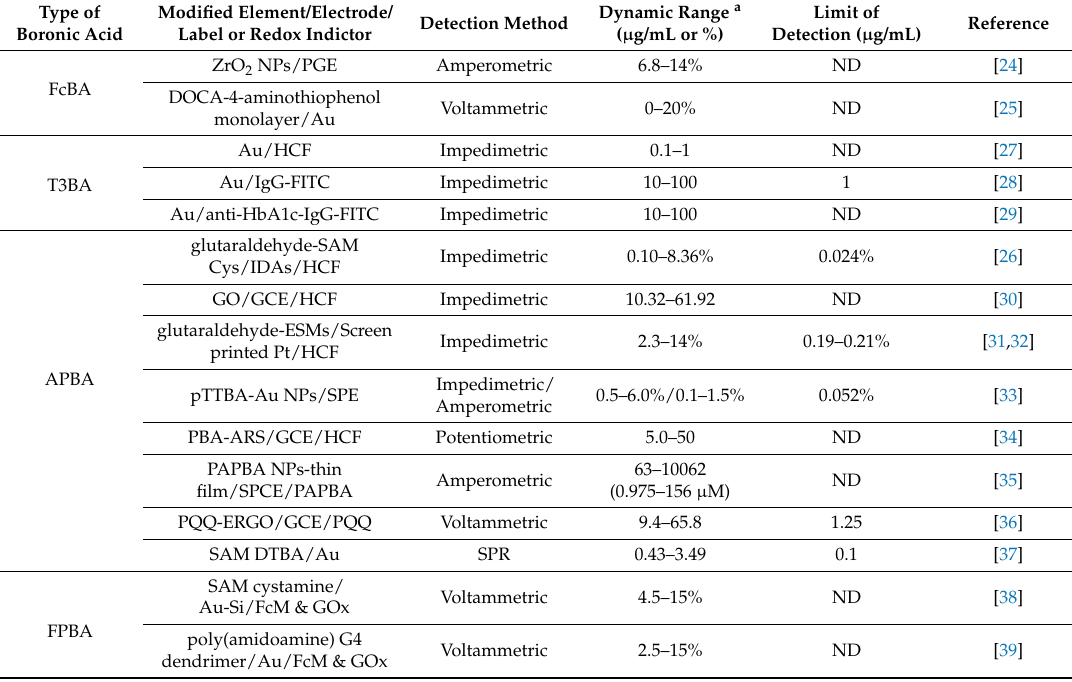
Table 2. Comparison of HbA1c biosensors based on boronic acid